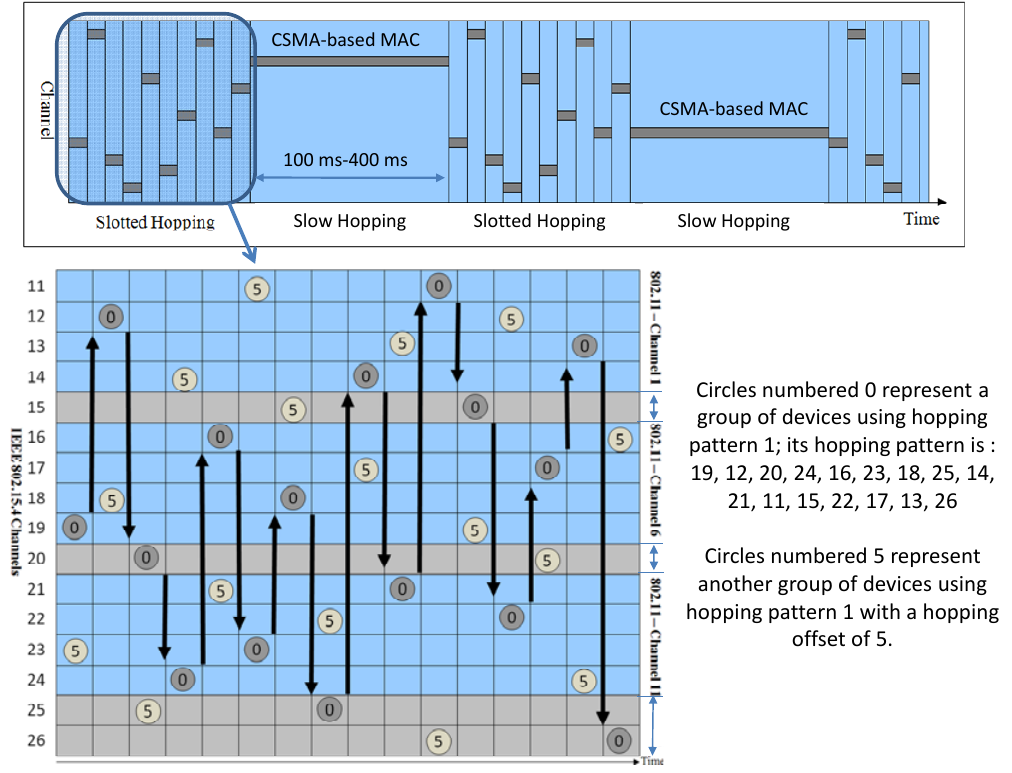
Figure 2. The ISA100.11a communication scheduling mechanism that alternates between a TDMA and CSMA-based